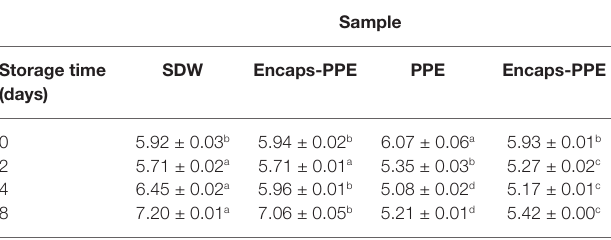
FIGURE 1 | Growth of total mesophilic bacteria (TMB) (A) , Enterobacteriaceae (B) , and Pseudomonas spp. (C) , evaluated up to 8 days of storage at 4 ± 1 ° C, on burger patties incorporating prickly pear extract (PPE) and encapsulated prickly pear extract (Encaps-PPE). Controls were made incorporating sterile distilled water (SDW) or encapsulated sterile distilled water (Encaps-SDW). Columns at the same storage time (0, 2, 4, and 8 days) followed by different letters are significantly different according to Fisher’s least significant difference test ( p < 0.05). Vertical bars indicate the standard deviation of the mean. SDW Encapsulated-SDW PPE Encapsulated-PPE. TABLE 2 | pH trends of beef burger patties incorporating prickly pear extract (PPE) or sterile distilled water (SDW) over 8 days of storage at 4 ± 1 °